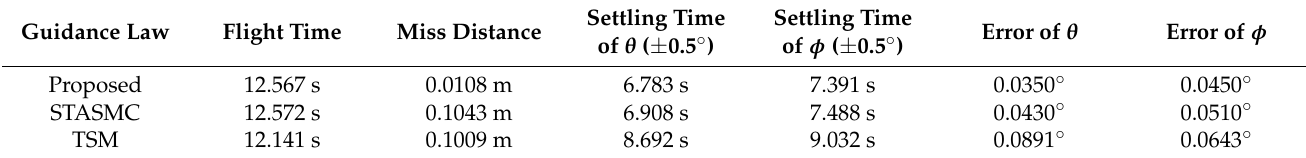
Table 4. Simulation results of scenario 2.